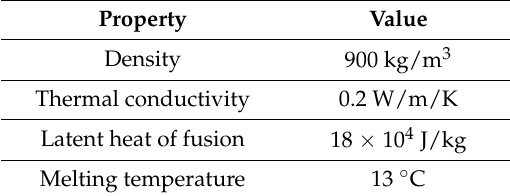
Table 1. Characteristics of the